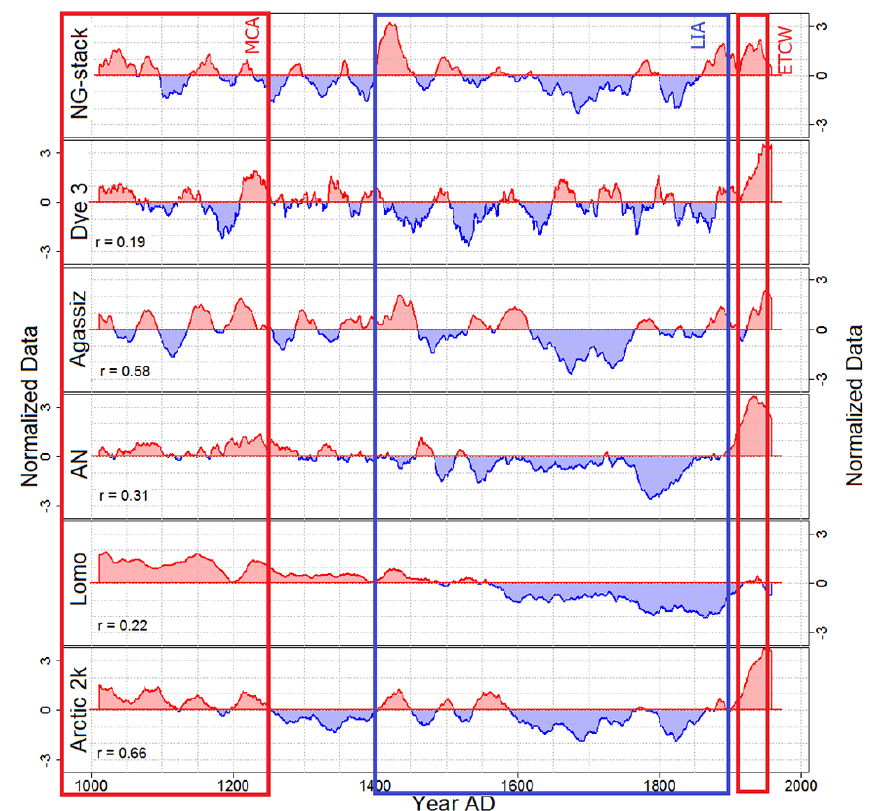
Figure 6. Thirty-year running mean for δ 18 O values from different Arctic regions – northern Greenland (NG stack, this study), southern Greenland (Dye3; Vinther et al., 2006b), Canada (Agassiz Ice Cap, Agassiz; Vinther et al., 2008), Russian Arctic (Akademii Nauk, AN; Opel et al., 2013) and Svalbard (Lomonosovfonna, Lomo, Divine et al., 2011) – as well as a reconstructed record (Arctic2k; Pages 2k Consortium, 2013). All records are given on z -level scales (centered and normalized data). The correlation coefficient for the smoothed values with regard to our stack is also